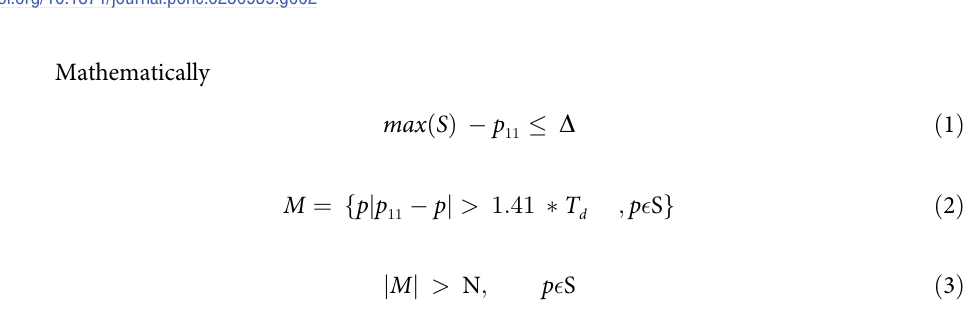
Fig 2. Pixel with discontinuity in BDCT